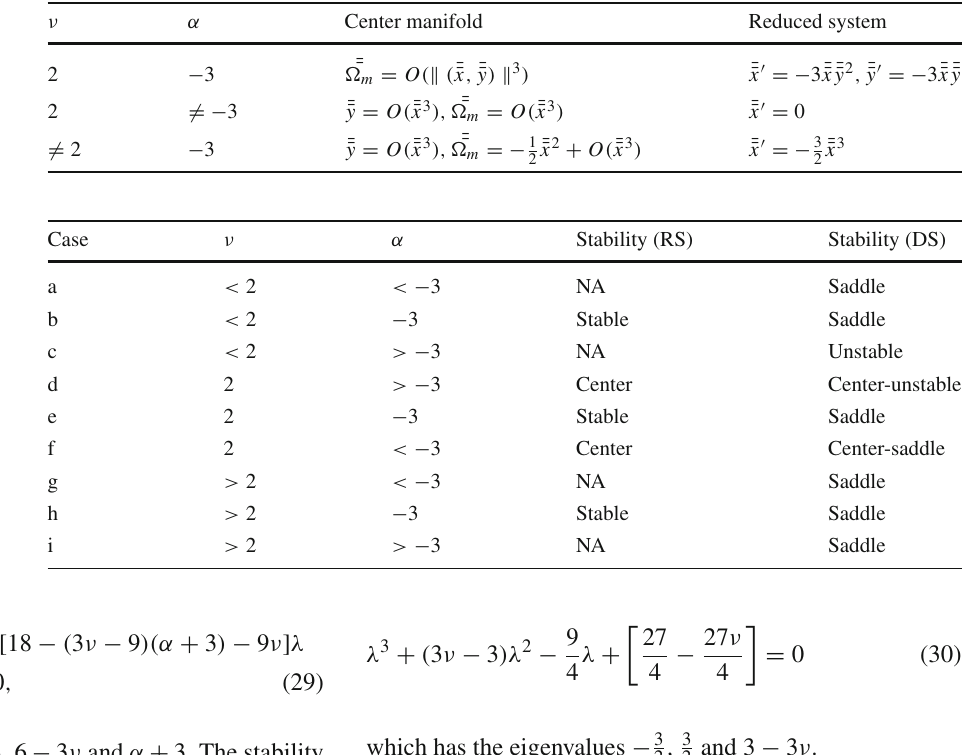
Table 5 C 2 (reduced system)